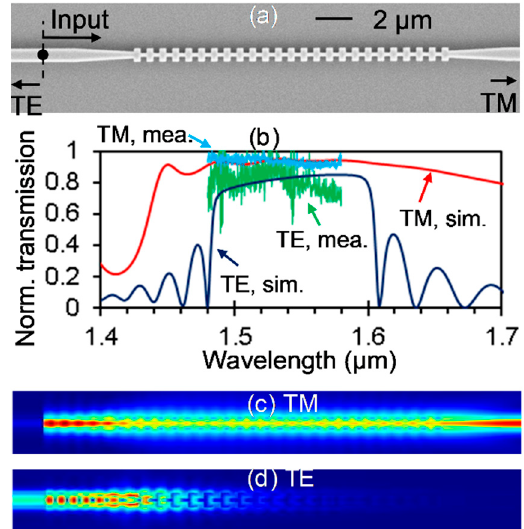
Figure 2. The fabricated in-line polarization beam splitter (PBS). ( a ) SEM image. ( b ) Simulated and measured spectra. Simulated light propagation at 1550 nm for the TM ( c ) and TE ( d ) modes.